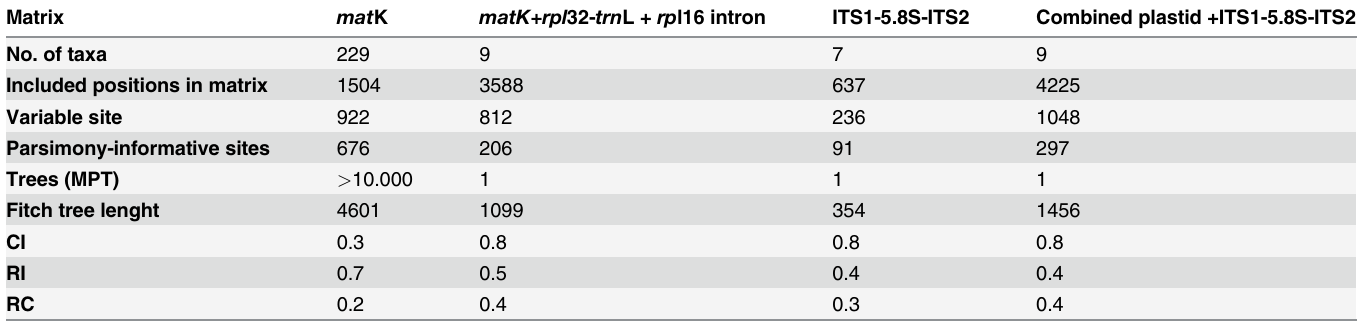
Table 1. Statistics for one of the parsimonious trees from all analyses (CI, consistency index; RI, retention index; RC, rescaled consistency index).